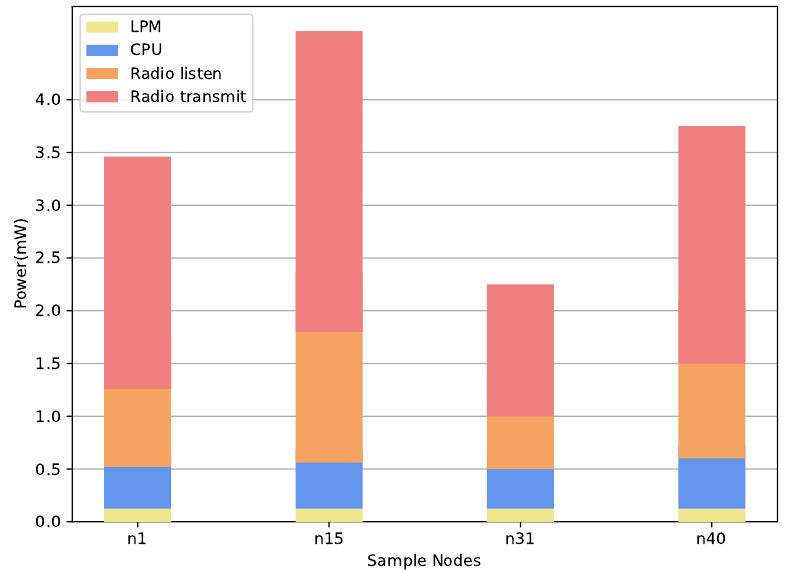
Figure 9. Instantaneous Power Consumption for nodes = [1, 15, 31,